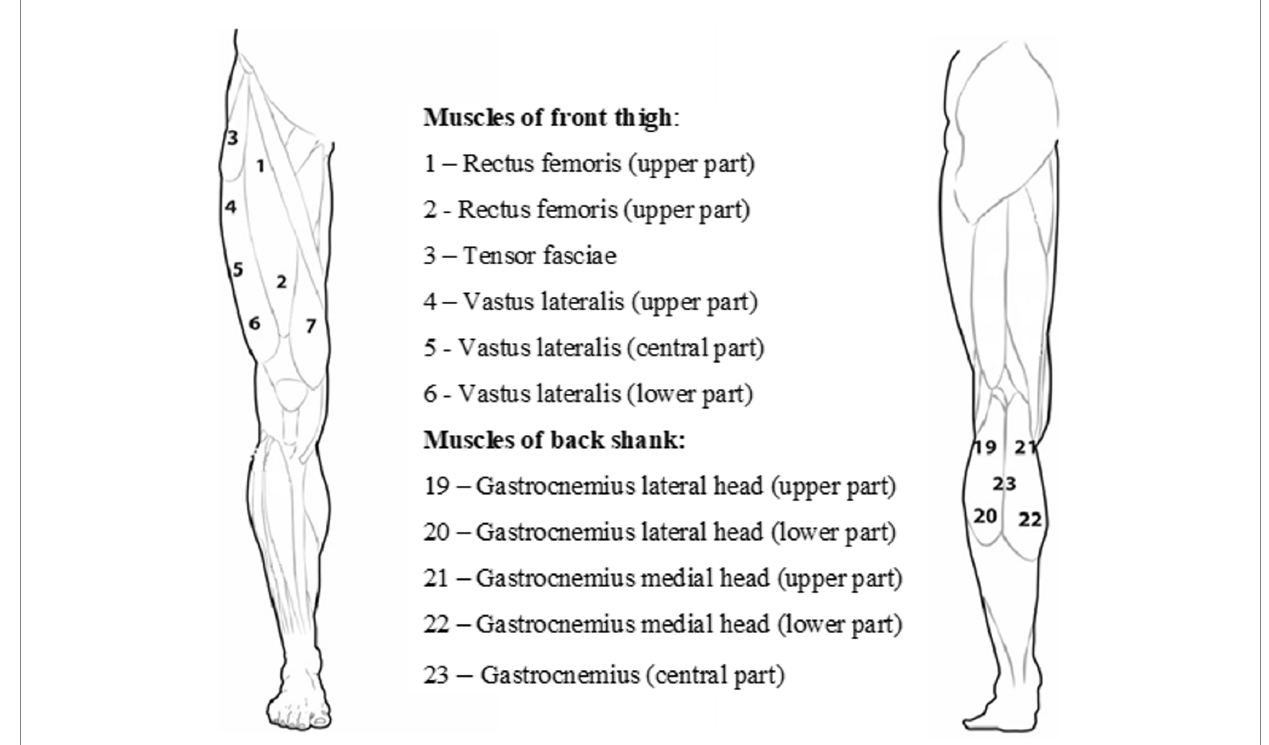
FIGURE 1 Arrangement of the measurement points of the quadriceps muscle of the thigh and the triceps muscle of the calf.